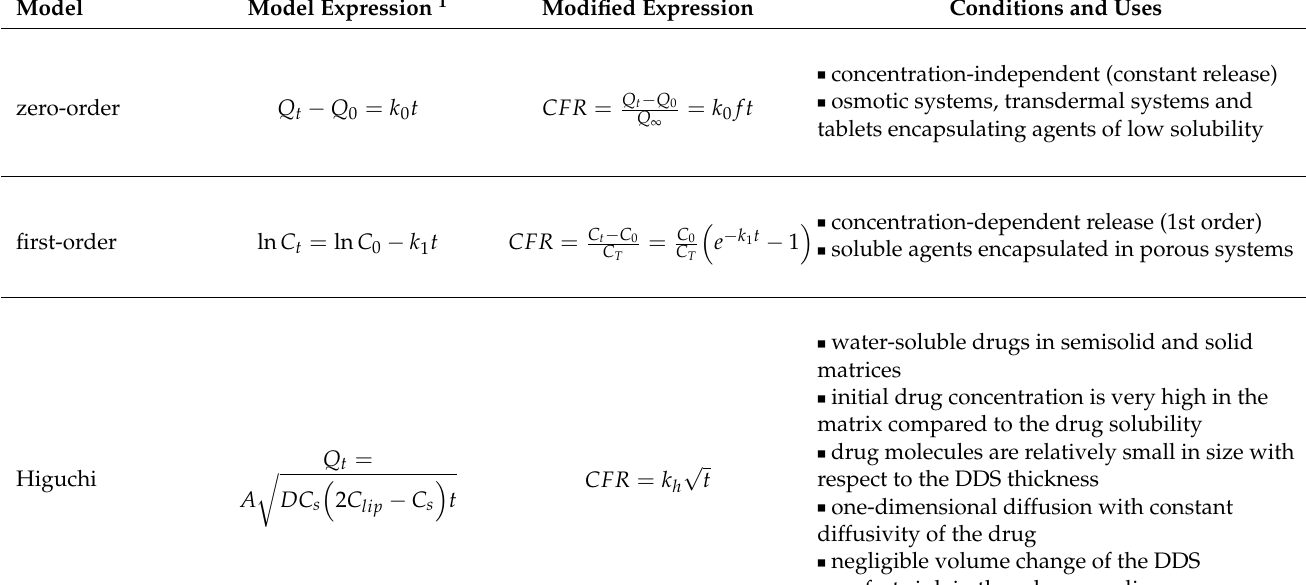
Table 1. The advantages and disadvantages of drug delivery trigger mechanisms.